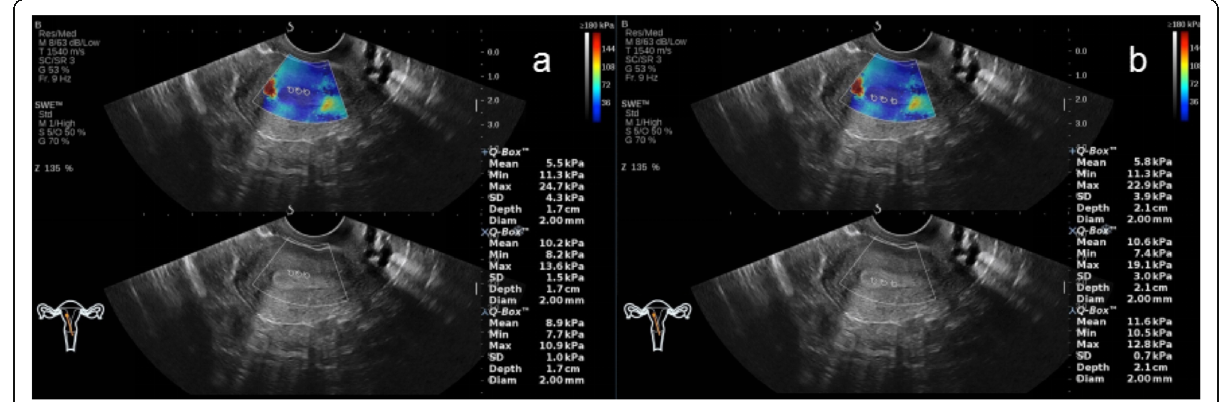
Fig. 3 Representative images of a woman in the NC group. a Young ’ s modulus at the three sites of the anterior endometrial wall was 5.5, 10.2, and 8.9 kPa, respectively; b Young ’ s modulus at the three sites of the posterior endometrial wall was 5.8, 10.6, and 11.6 kPa, respectively. The mean Young ’ s modulus of the six sampling sites was 8.8